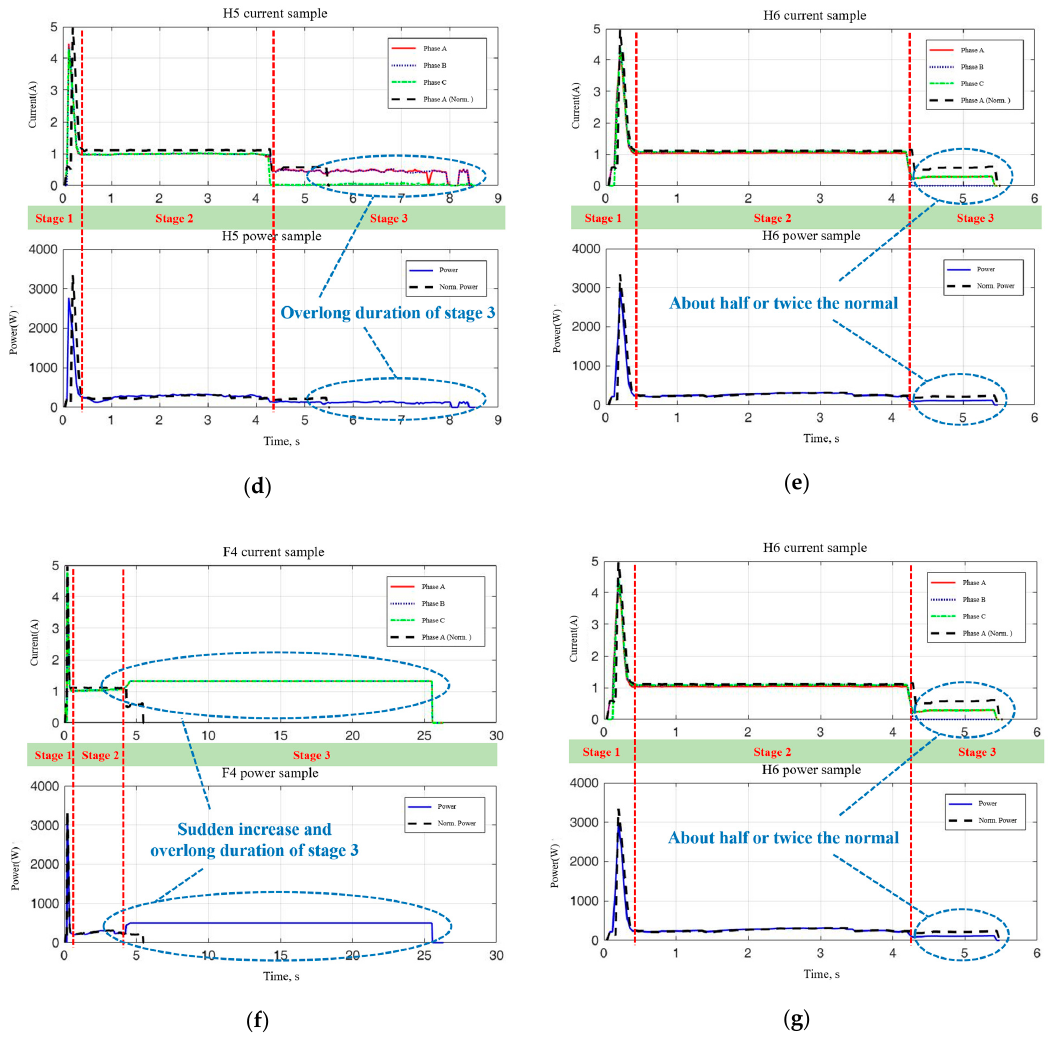
Figure 3. Current and power data of normal and fault types of turnout system. ( a ) Normal sample of current and power curve; ( b ) sample of fault H1; ( c ) sample of fault H4; ( d ) sample of fault H5; ( e ) sample of fault H6; ( f ) sample of fault F4; ( g ) sample of fault F5.